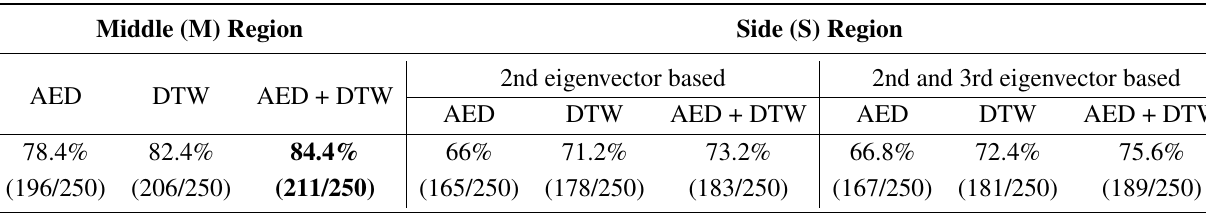
Table 6. Results of recognition rate of proposed face recognition based on middle (M) and side (S) face regions (Rank-1